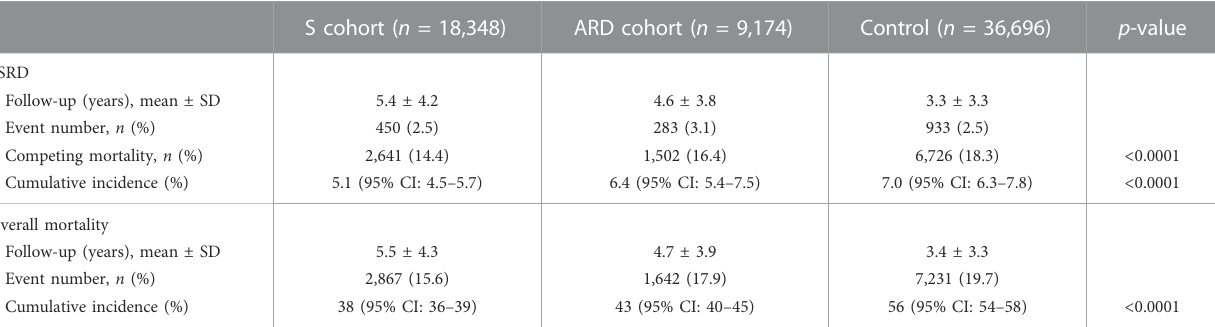
TABLE 2 End-stage renal disease occurrence and overall mortality over a 15-year follow-up